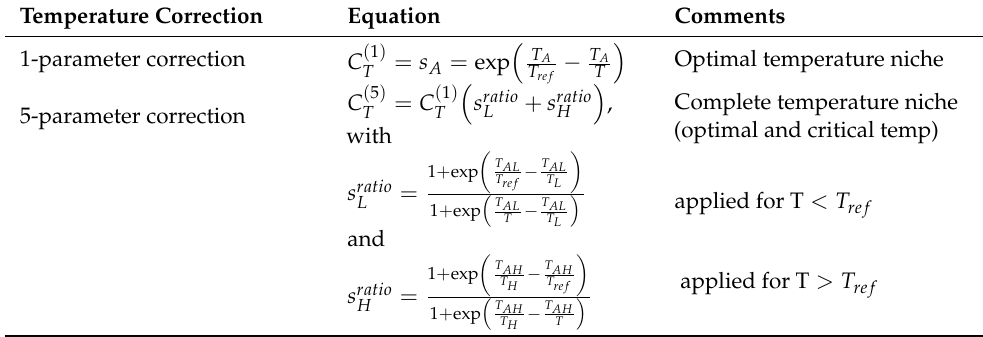
Table A2. Temperature correction, coded as DEBtool function tempcorr.m. Parameters are as follows: T ref —reference temperature, T A —Arrhenius temperature, T AL —low Arrhenius